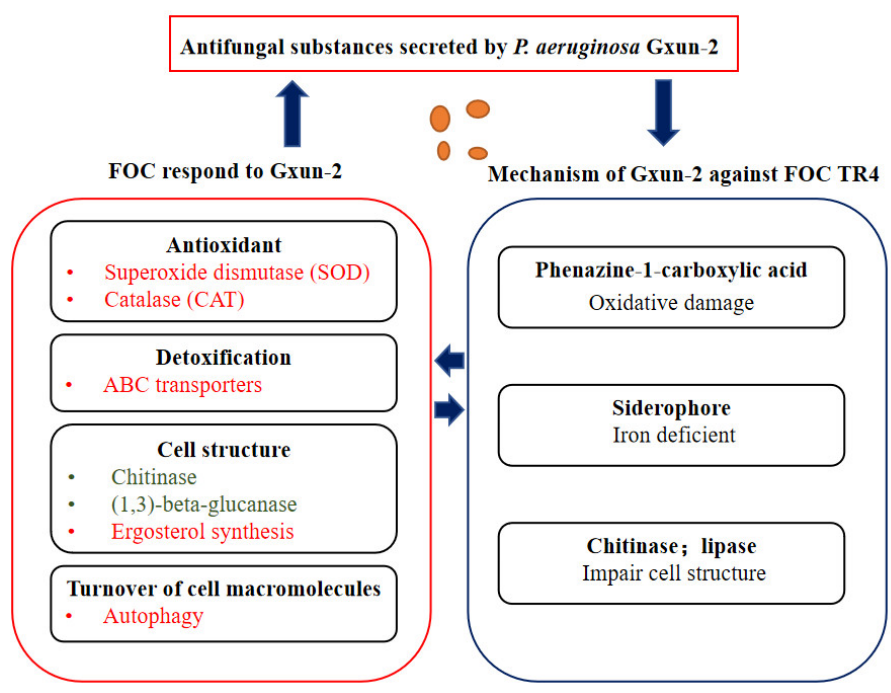
Figure 10. Pattern of interaction between FOC TR4 and Gxun-2.